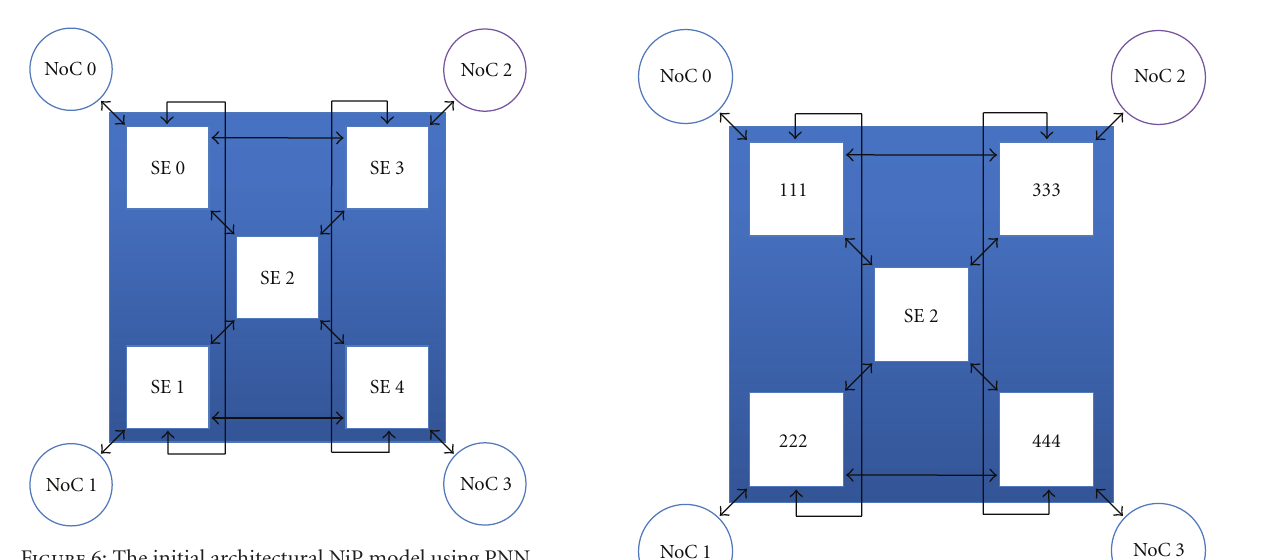
Figure 6: The initial architectural NiP model using PNN.